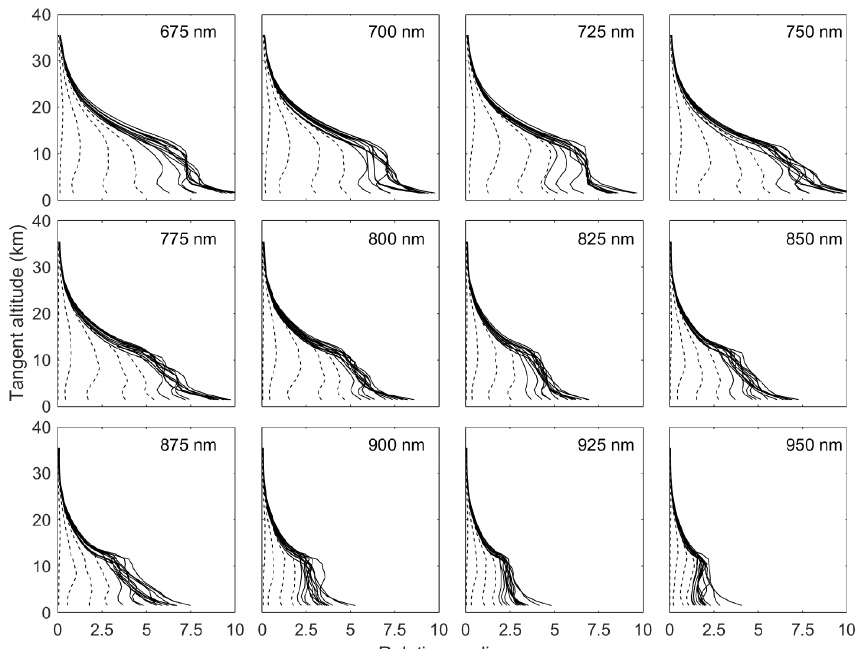
Figure 10. Averaged ALI relative radiance vectors from 12 of the 13 wavelengths from the NIMBUS 7 flight. Each panel presents the radiance vectors from a different wavelength measured which is denoted in the top right corner. The dashed lines are radiance profiles where the solar zenith angle is greater than 90 ◦ and solid lines are profile where the solar zenith angle is less than 90 ◦ . The separation between each consecutive radiance vector at each wavelength is approximately 2 ◦ in solar zenith angle.